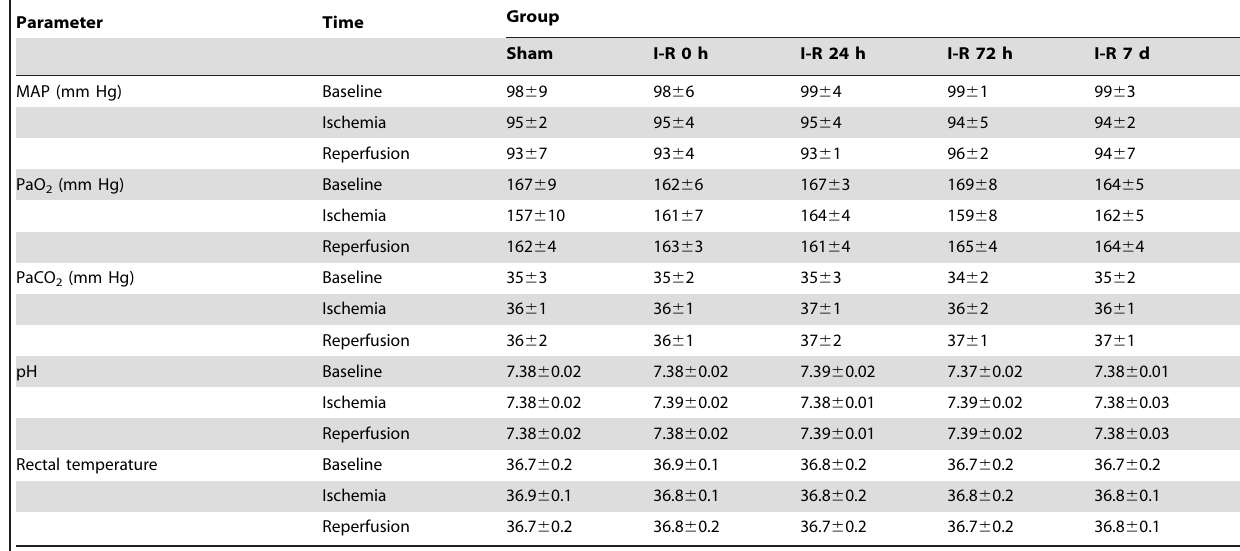
Table 3. Physiological parameters.